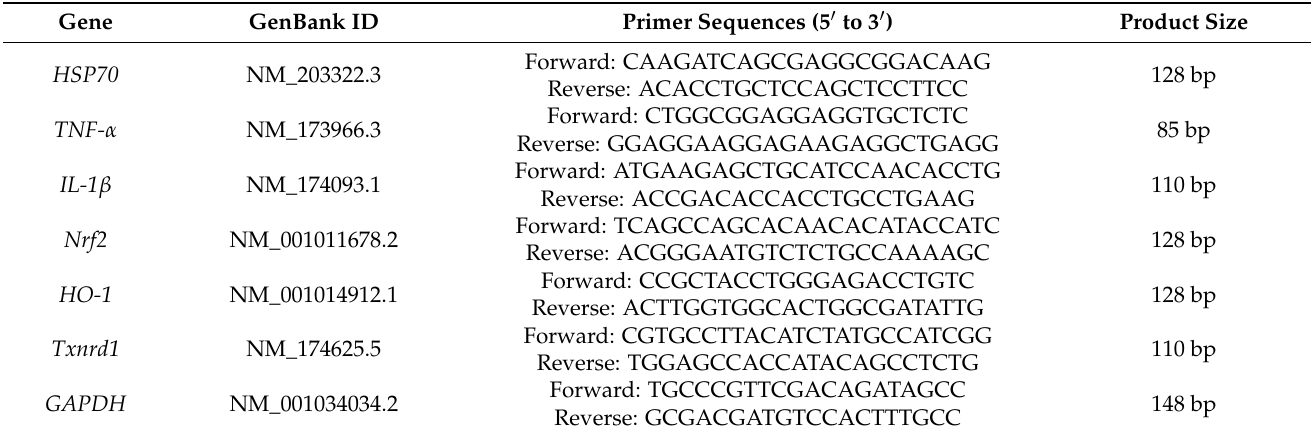
Table 1. Primer sequences for quantitative real-time